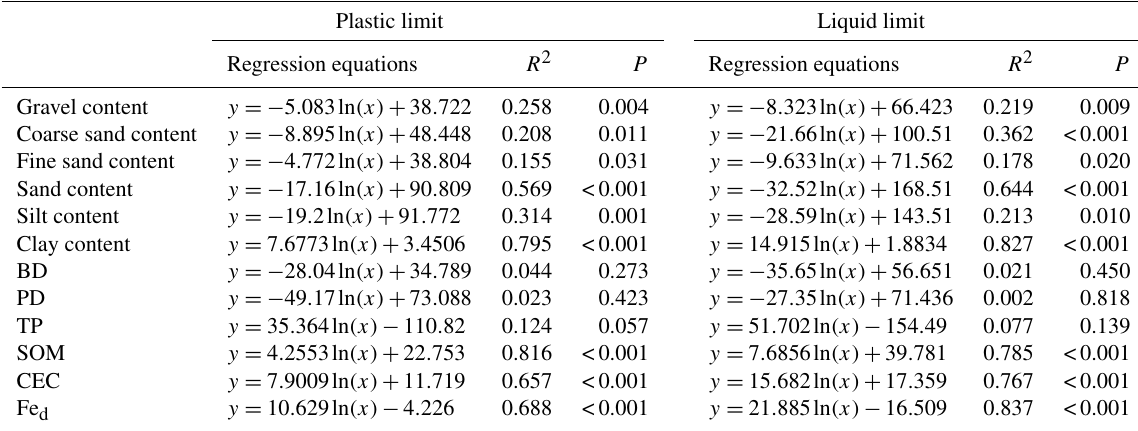
Table 6. Regression and correlation analyses of soil Atterberg limits with soil physicochemical